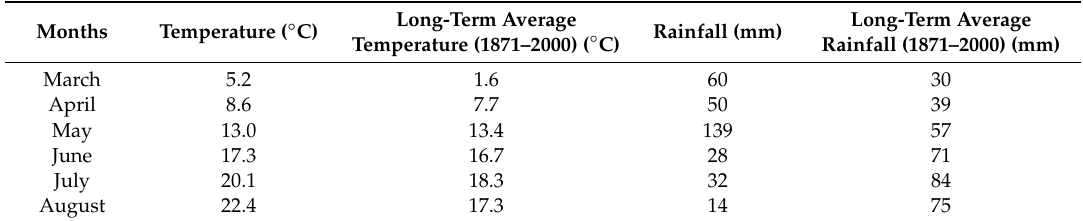
experimental farm in